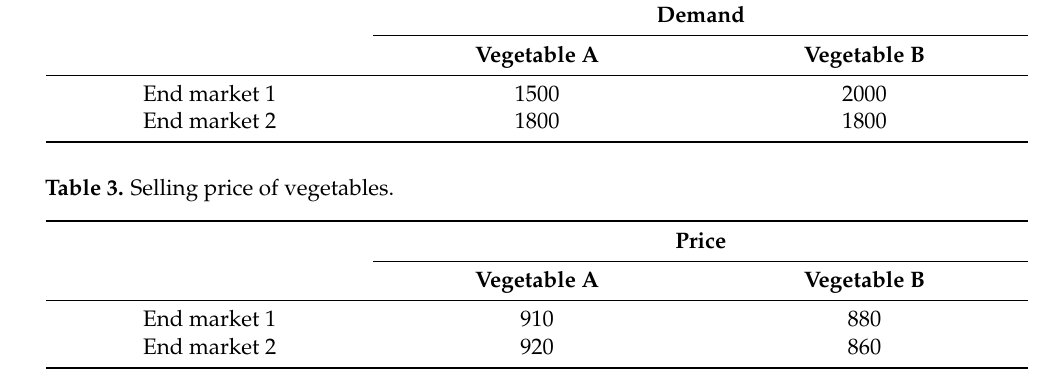
Table 4. Amount of product available from each farmer.